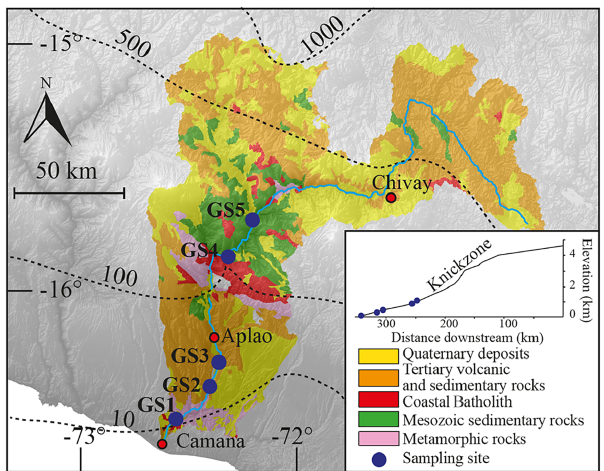
Figure 3. Geological map of the Majes basin overlain by the pre- cipitation pattern (precipitation data from Steffen et al., 2010), in which the black dashed lines show precipitation rates (mmyr − 1 ). GS1 to GS5 represent sites where grain size data have been col- lected. The right corner shows the Majes river long